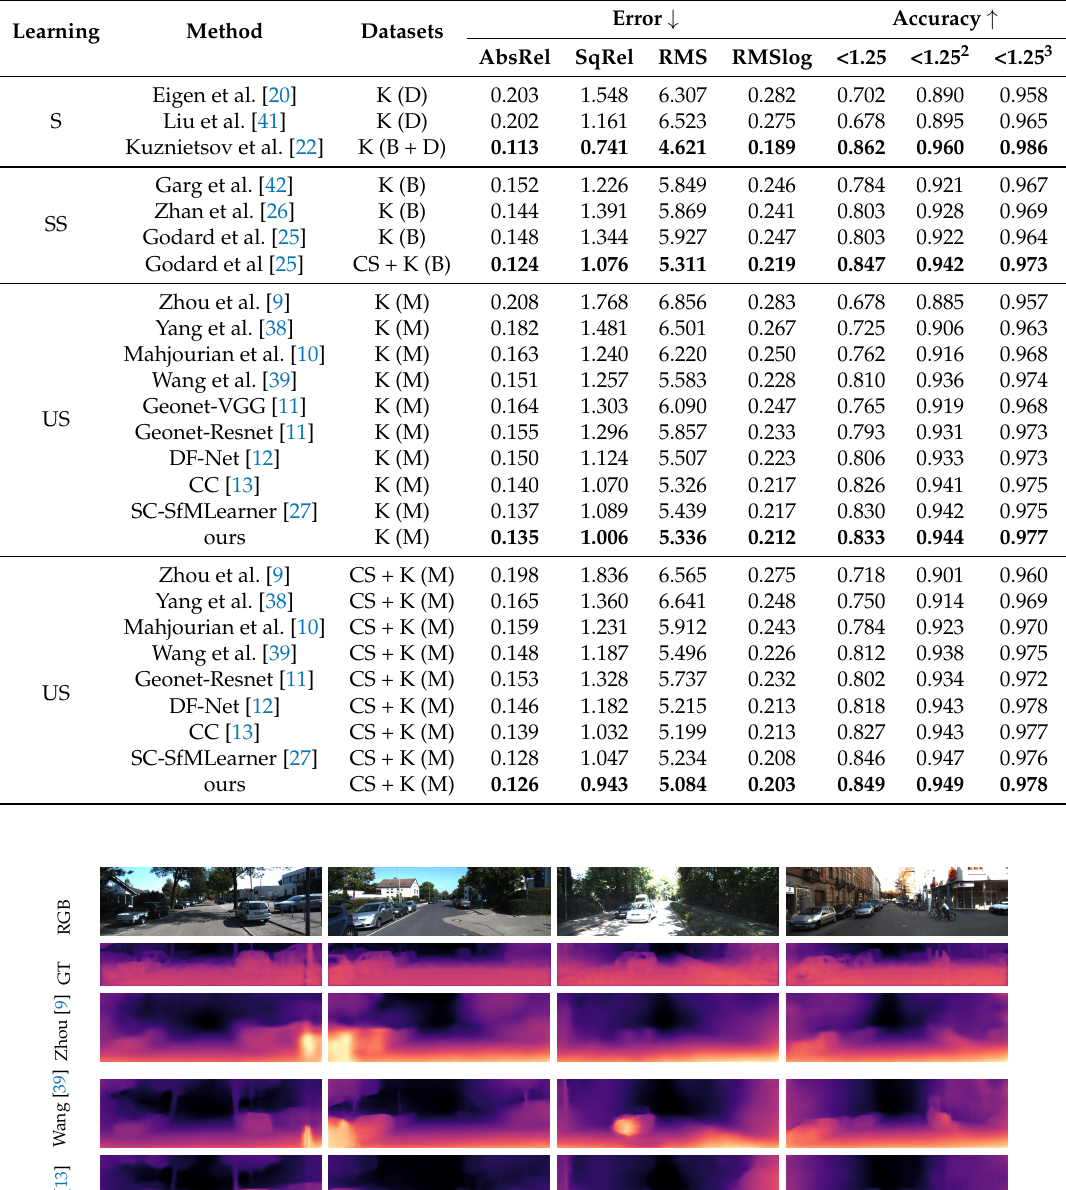
Table 1. The result of depth estimation. K represents the use of KITTI raw data for training while CS + K represents the use of both the Cityscapes and the KITTI raw data. B represents the training with binocular images. D represents using depth groundtruth as supervision signal, and M is for monocular video. S represents the supervised method, SS represents semi-supervised method and US represents unsupervised method. For the error, the lower is better and for the accuracy, the higher is better. The details of the indicators can be seen in Appendix D.